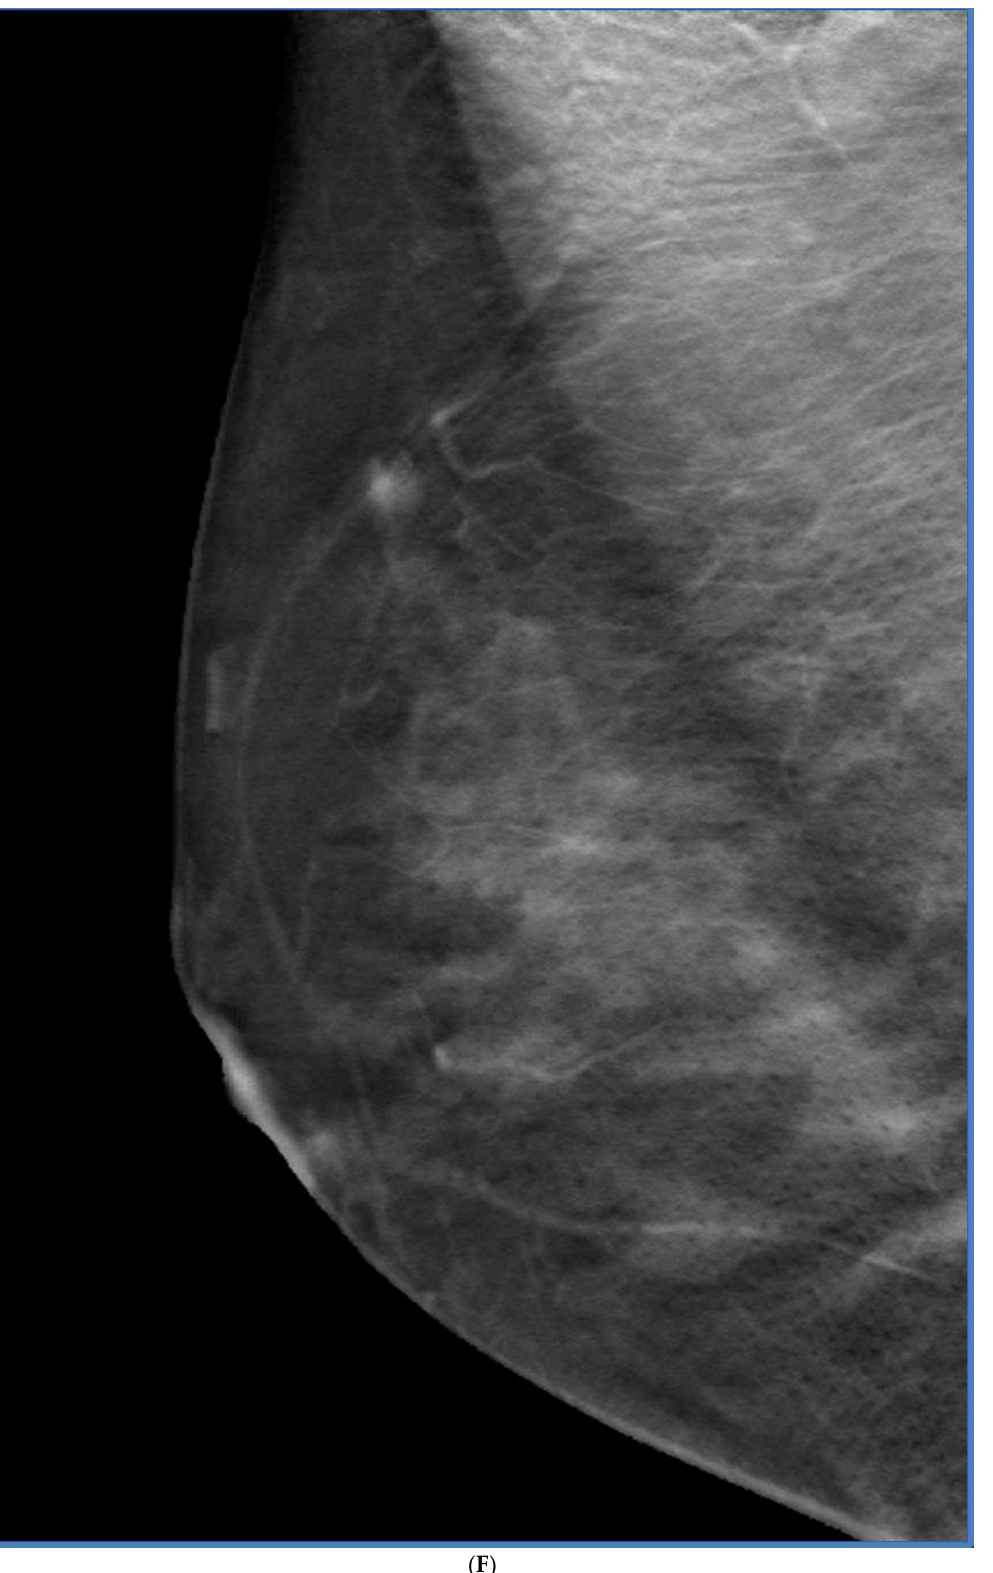
Figure 6. Courtesy of Dr. Regina Hooley. Three cancers seen on screening US, that were missed on DBT: Mass #1 ( A ) US and ( B ) DBT; Mass #2 ( C ) US and ( D ) DBT; Mass #3 ( E ) US and ( F )